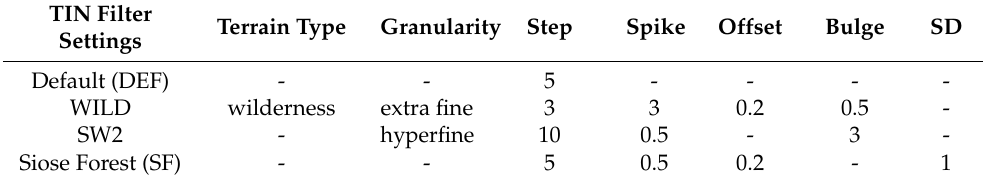
Table 4. Settings of the progressive TIN densification filter used in LasTools software. The setting called Siose Forest (SF) came from the methodology followed to classify low-resolution LiDAR (PNOA) in the Spanish region of La Rioja (https://www.iderioja.larioja.org/ (accessed on 21 December